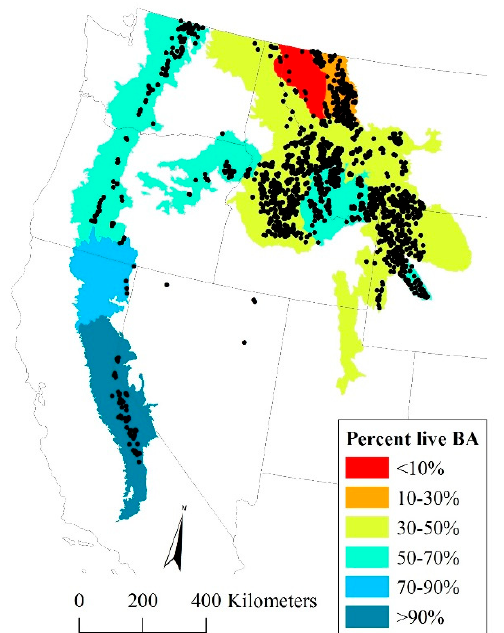
Figure 1. Locations of 1406 forest inventory plots (black dots) with live or dead whitebark pines in the western US, with percentage of standing whitebark pine trees ≥ 2.54 cm diameter at breast height that are alive within each eco-province (aggregated from the ecological subsections of Cleland et al. 2007 [19]), based on plots measured between 2007 and 2016. Provinces in the central Great Basin are not shown due to small sample size. Plot locations are approximate.